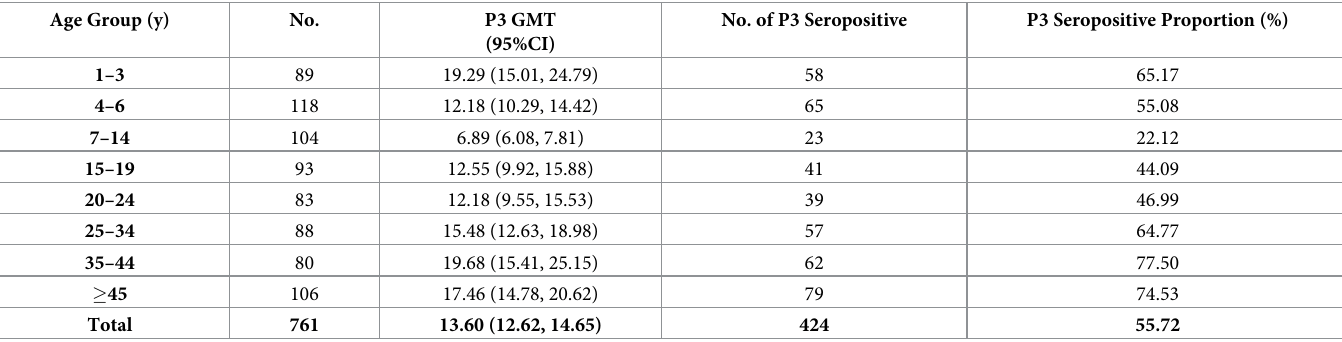
Note: No. means the number of participants in the corresponding category; P3 means P3 strain of JEV; No. of P3 Seropositive means the number of participants who were seropositive against P3 strain. P3 Seropositive proportion means the proportion of participants with seropositive antibody level against P3